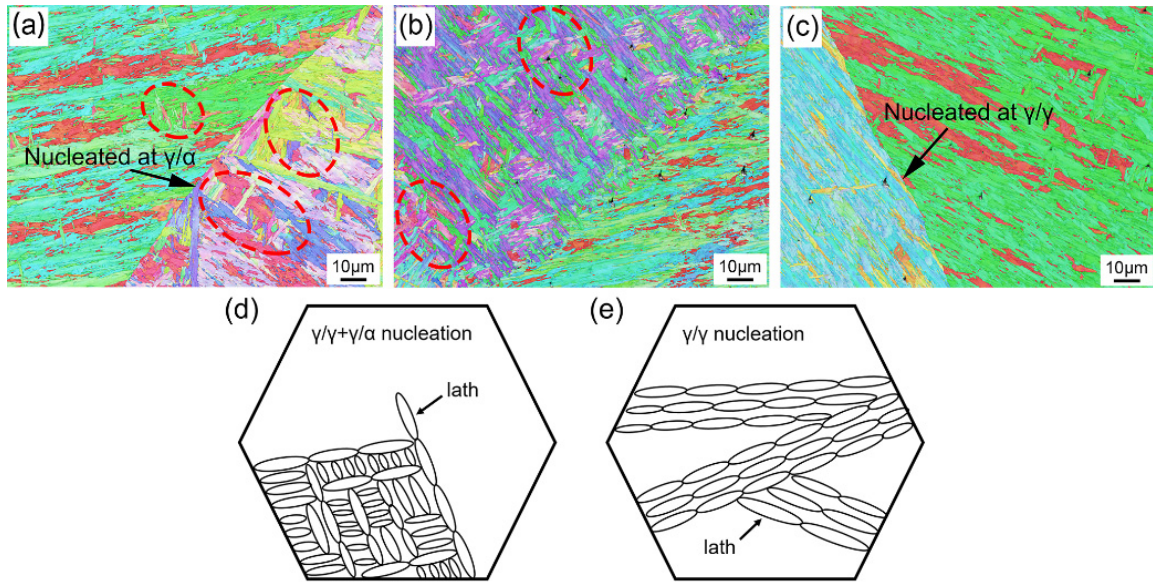
Figure 9. ( a – c ) are IPF images of Ni5.5, Ni6.5, and Ni7.5, respectively, and the red circle represents the place where autocatalytic nucleation occurs; ( d , e ) are the schematic diagrams of the nucleation method in the deposited metals.